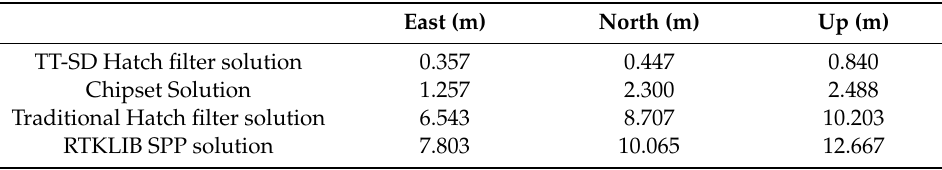
Table 1. Comparison of static positioning errors in terms of RMS